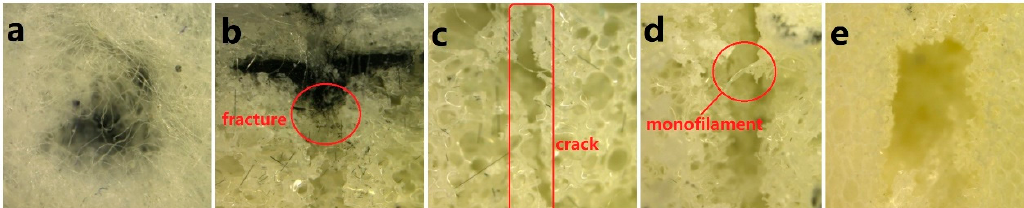
Figure 10. Microscopic images of breaking section of N/C-FU0-0.5/S. ( a ) impact fracture of surface nonwoven fabric; ( b ) cross section of the upper interface of carbon fabric and foam; ( c ) cross section of upper layer of foam; ( d ) cross section of lower layer of spacer fabric; ( e ) impact fracture of lower layer of foam.